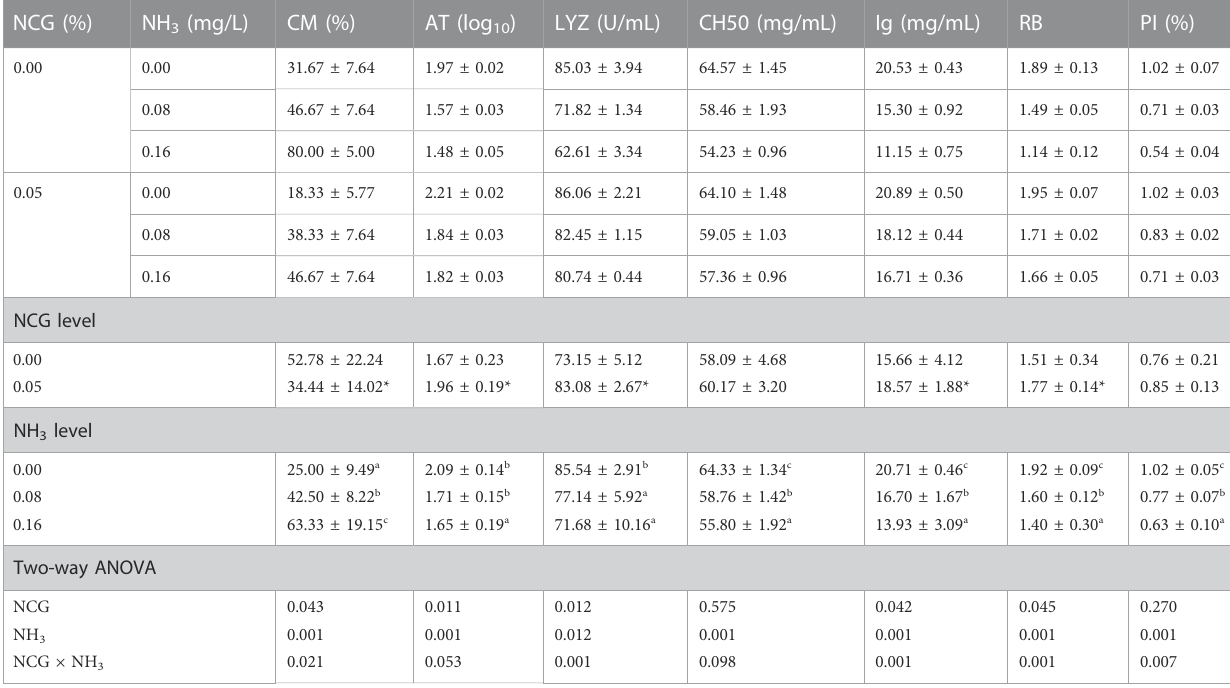
TABLE 9 Effects of dietary N -carbamylglutamate supplementation and ammonia stress on cumulative mortality and serum immune response of yellow cat fi sh 7 days post-challenge with A. hydrophila